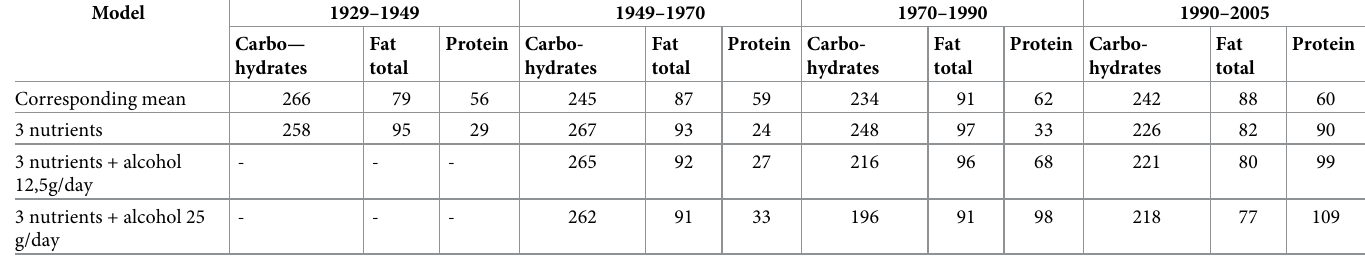
Table 4. Comparison of the mean availability of macronutrients in the corresponding periods of precedence with predicted optimal proportions of macronutrients in grams per day assuming 2000 kcal diet. Calculated from models without alcohol and with two levels of alcohol consumption: 12.5 or 25 g pure ethanol daily corre- sponding to half or one standard drink a day, respectively. It should be mentioned that standard drink that we have used differs from US standard drink which contains 14g of pure